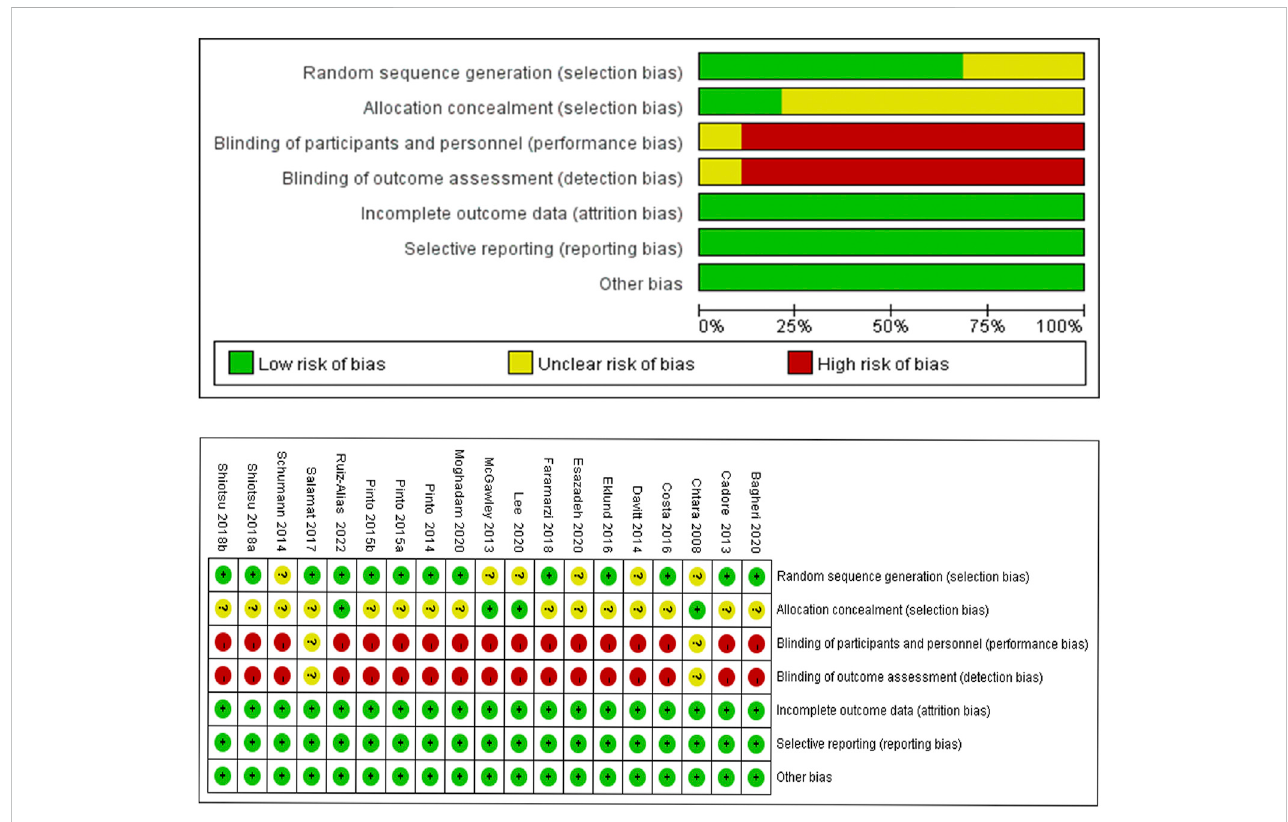
FIGURE 2 Summary of risk of bias of the studies